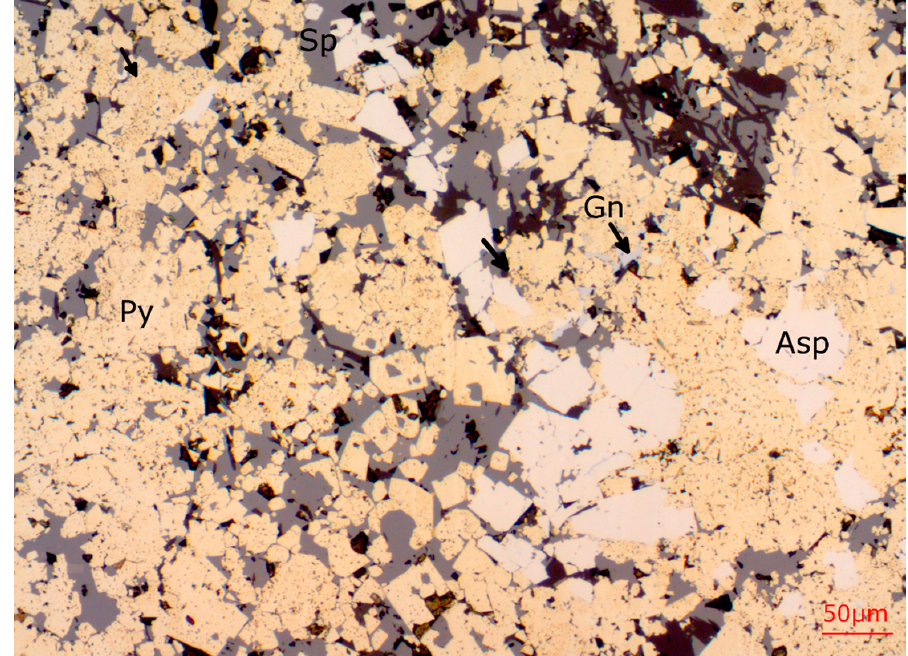
Figure 8. Reflected light photomicrograph from L4-14-132.0 polished thin section. Subhedral Asp grains are isolated within Py aggregates, while coarse Asp euhedra are present at the grain boundaries of pyrite-Sp aggregates. Sphalerite is interstitial phase to Py-Asp assemblage.